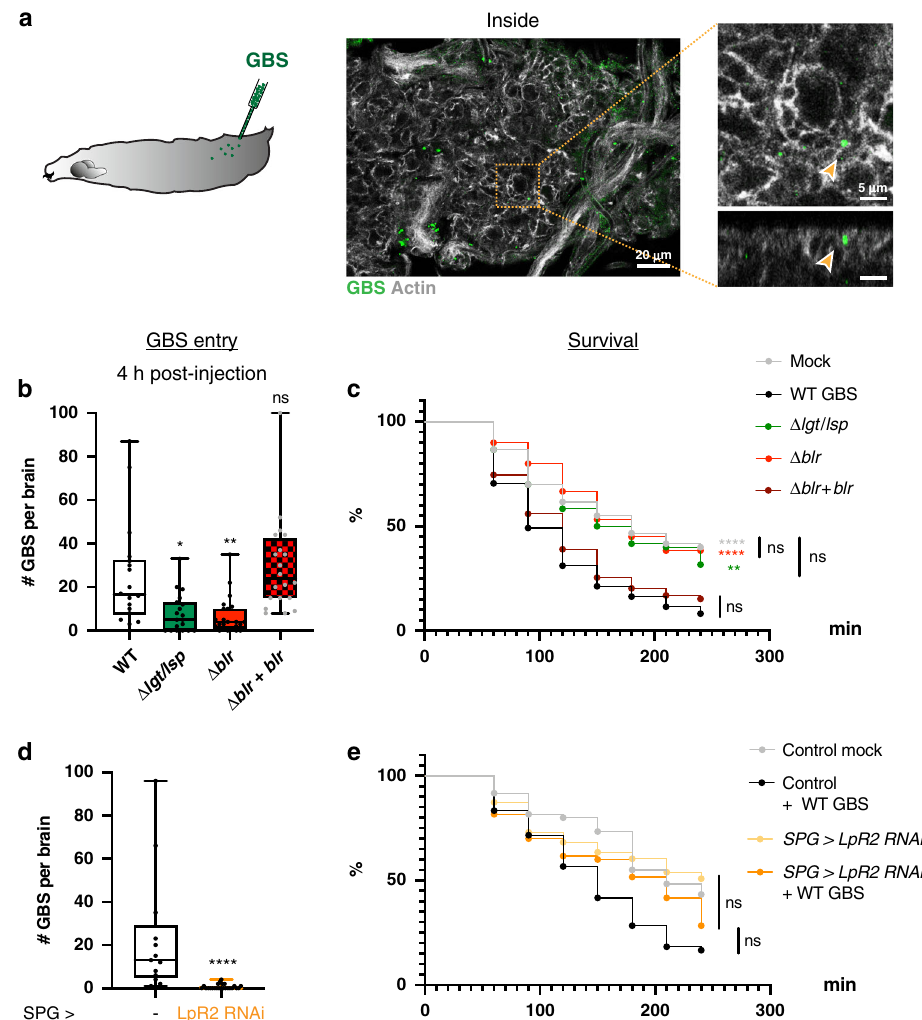
Fig. 5 An in vivo model of brain infection in Drosophila identi fi es Blr as a virulence factor and con fi rms LpR2 as a BBB receptor for brain invasion by GBS. a Schematic representation of Drosophila third instar larva injected with GBS. Confocal picture and close-up (top and orthogonal views) showing